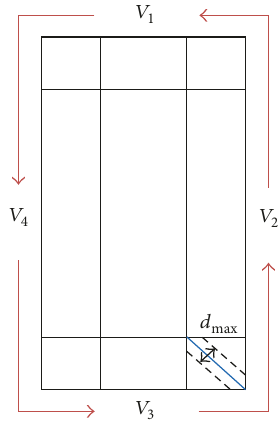
Figure 5: The illustration of ring color matching method. Table 1: Comparison of different corner detection